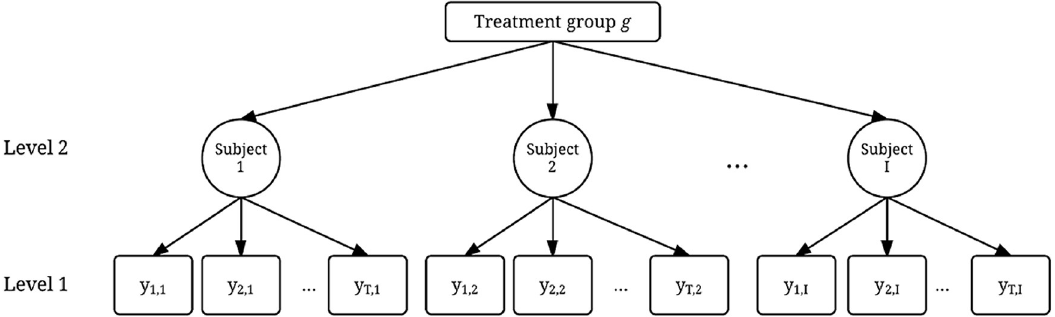
Fig 1. A generalized form of a multilevel structure for one group. The measurements are in level one for time point t = 1, 2, ... , T for subject y = 1,2, ... ,N. The subjects are level 2 and combined in one treatment group.